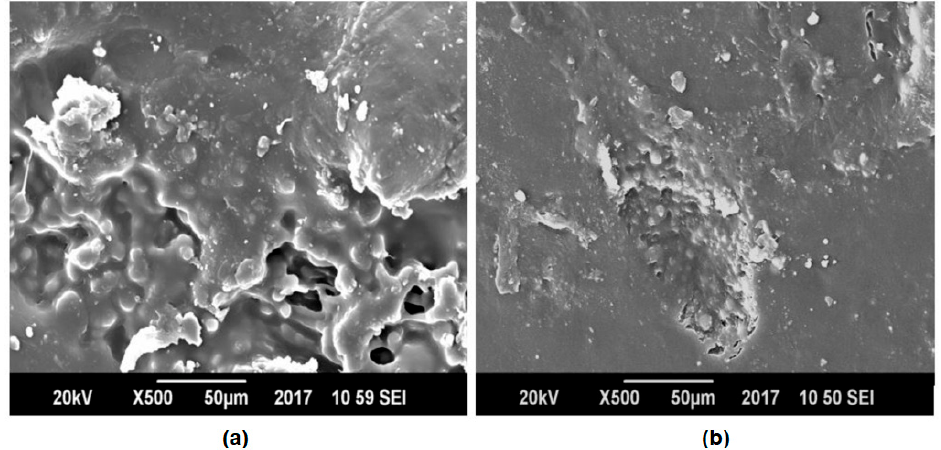
Figure 10. SEM images of ( a ) PP/PET and ( b ) Maleic Anhydride grafted Polypropylene/ Polypropylene/ Polyethylene Terephthalate (MAH ‐ g ‐ PP/PP/PET) blends with composition 40/60 and 2.5/37.5/60, respectively.